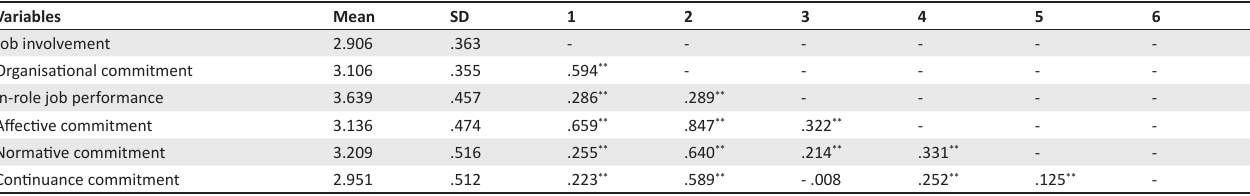
TABLE 1: Mean, standard deviation, Cronbach and correlation.